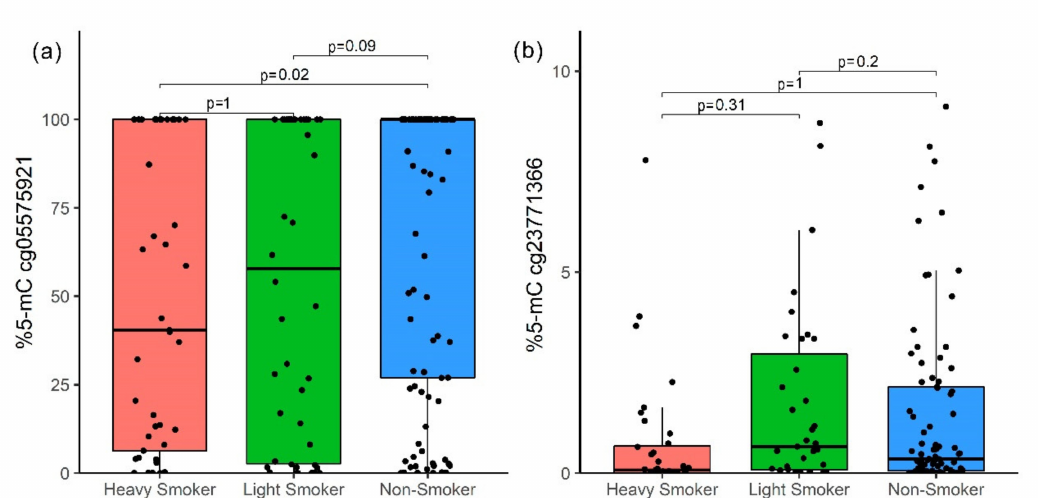
Figure 3. Methylation percentage comparison between HS, LS, and NS; p -value by Bonferroni correction. ( a ) cg05575921 ( AHRR ) site and ( b ) cg23771366 ( PRSS23 ) site. The p -value was obtained by the Kruskal–Wallis test with a post-hoc Dunn test.